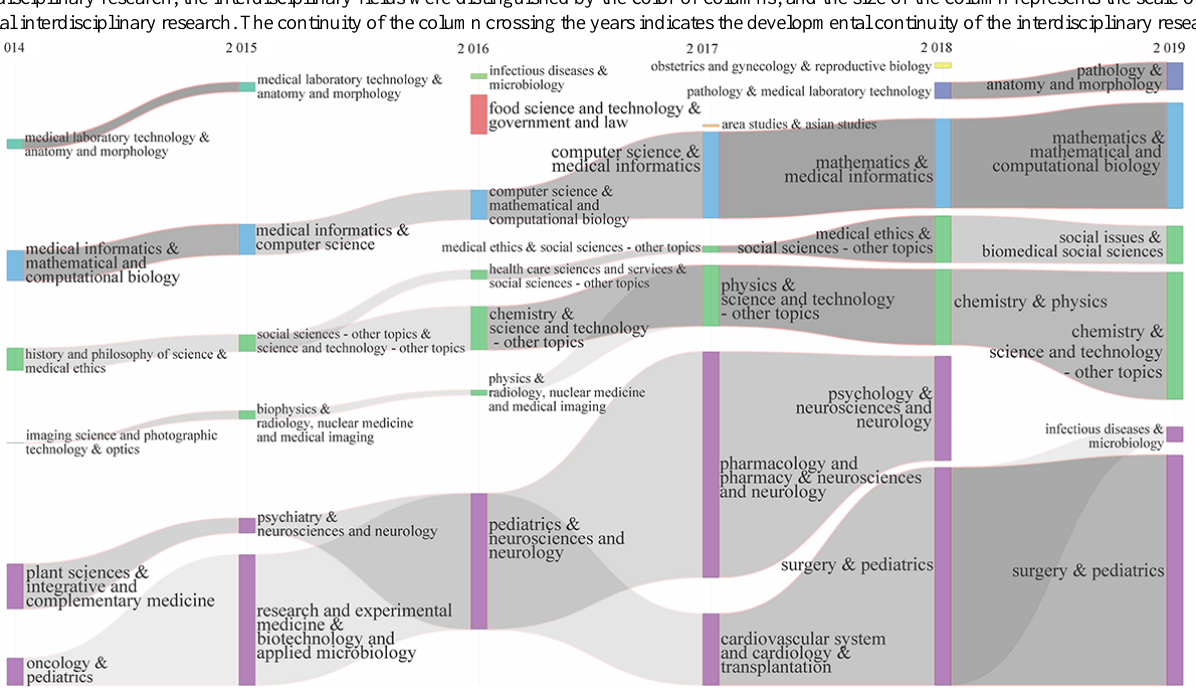
Figure 9. Evolution of interdisciplinary collaboration of precision medicine research over time (2014-2019). The column represents a special interdisciplinary research, the interdisciplinary fields were distinguished by the color of columns, and the size of the column represents the scale of the special interdisciplinary research. The continuity of the column crossing the years indicates the developmental continuity of the interdisciplinary research.